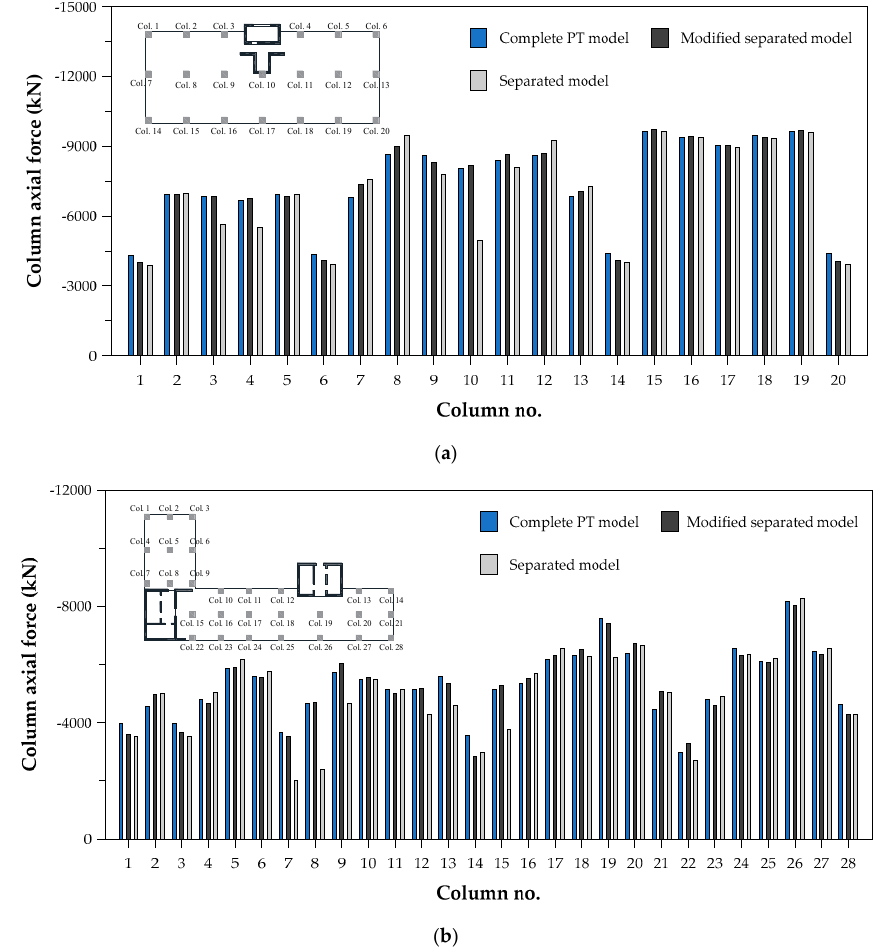
Figure 10. Comparison of column axial force under gravity load according to the modeling method (with load transfer through core walls) ( a ) Flat-shape plan and ( b ) L-shape